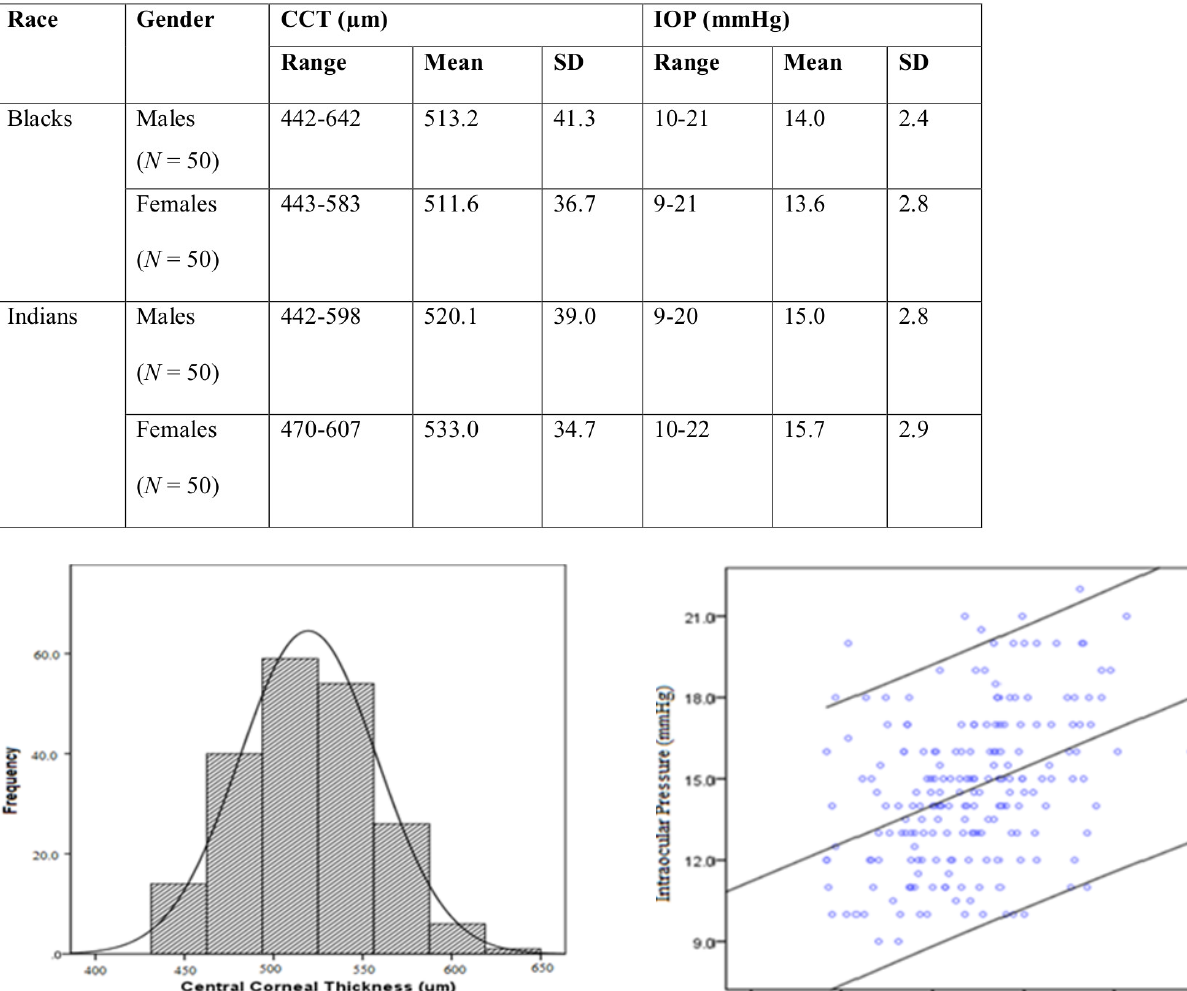
Table 3: Showing the range, mean and SD of CCT and IOP in relation to gender in the two race groups. The mean CCT and IOP values in Indian females are greater than those of Indian males, Black males and Black